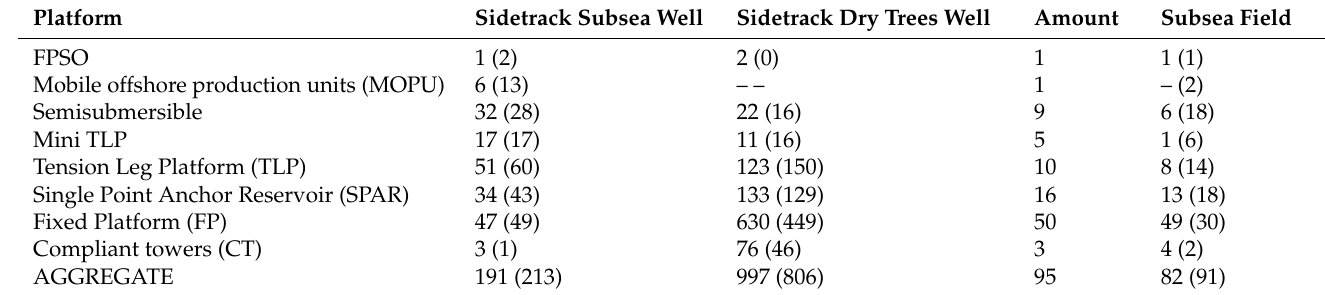
Table 1. Inventory of deep water platforms in GoM; (Courtesy: BOEM, data retrieved in